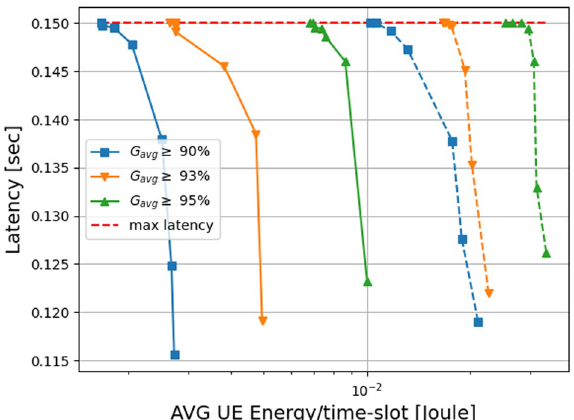
Fig. 5 UE energy/latency trade-off for ensemble learning (solid) and deep-CE only (dashed). This figure makes a comparison of the trade-offs between the energy consumption of the UE obtained with a compression system which encompasses only the deep-CE and a compression system composed of all the considered compression strategies